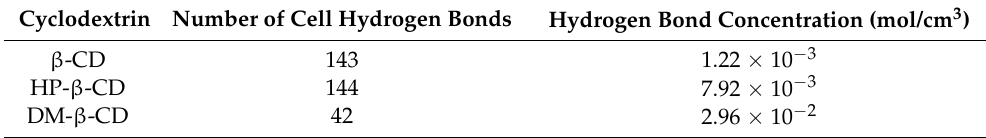
Table 5. Number of hydrogen bonds and hydrogen bond concentration in the three cyclodextrin cells. Cyclodextrin Number of Cell Hydrogen Bonds